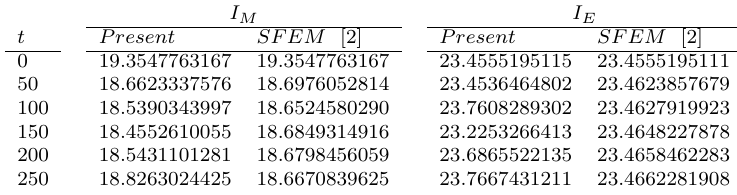
Table 4. Comparison of conserved quantities for the interaction of two solitary waves with a = b = c = 1, d = 0 . 5, h = ∆t = 0 . 1, v 1 = 0 . 3, v 2 = 0 . 5, x 1 = − 70 and x 2 = − 35. I M I E t